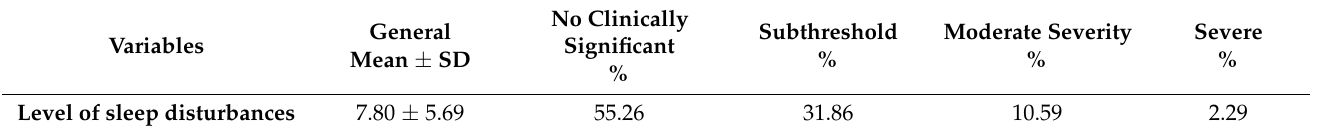
Table 3. Evaluation of the sleep disturbances among Poles n =